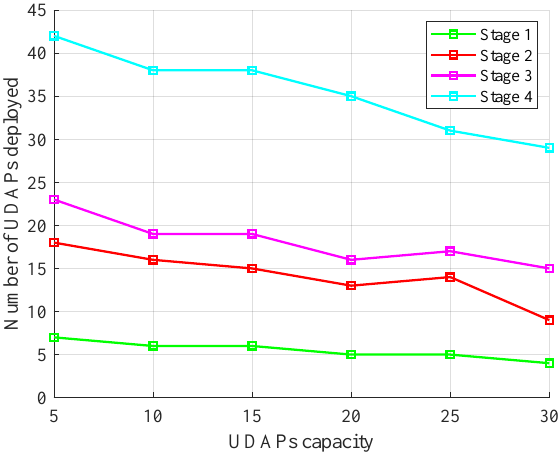
Figure 5. Number of concentrators deployed, according to their